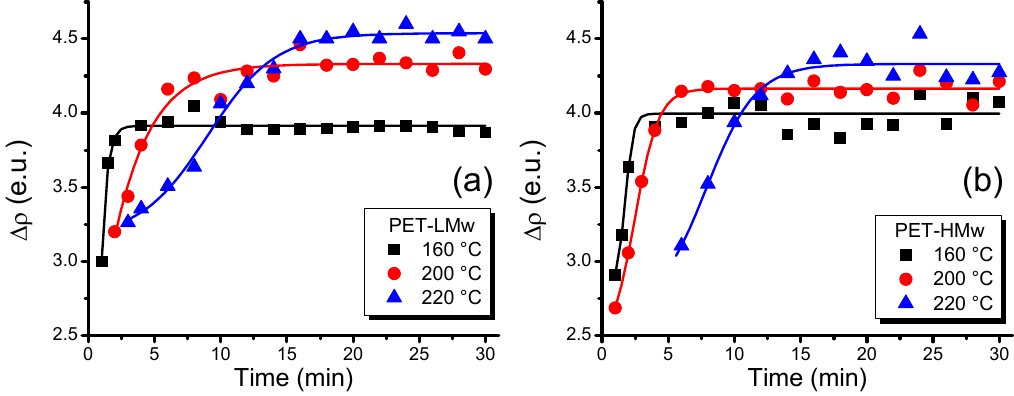
Figure 13. Evolution of electron density ( ∆ρ ) of isothermally crystallized PET at different temperatures: ( a ) PET-LMw; and ( b ) PET-HMw. Data were obtained from time-resolved SAXS